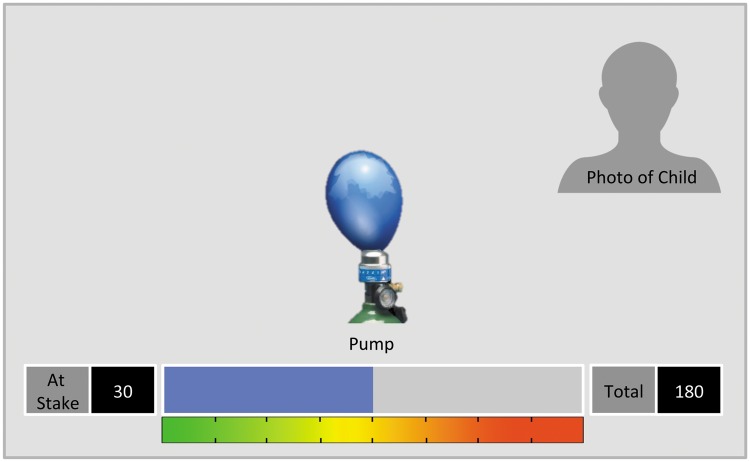
Schematic depiction of the BART during the pumping phase. The photograph of the child was either of themselves (alone condition) or of a peer (observed and peer pressure conditions). We do not have permission to print the actual photographs used in the study.